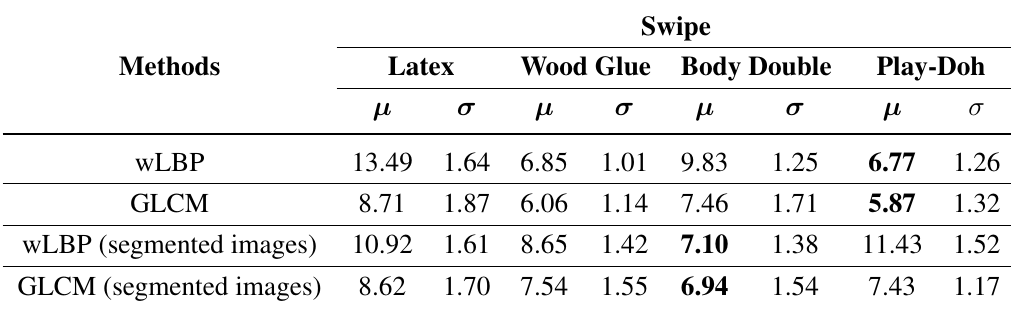
Table 5. ACER for each material of the Swipe dataset, study 1 (ACER in % ).